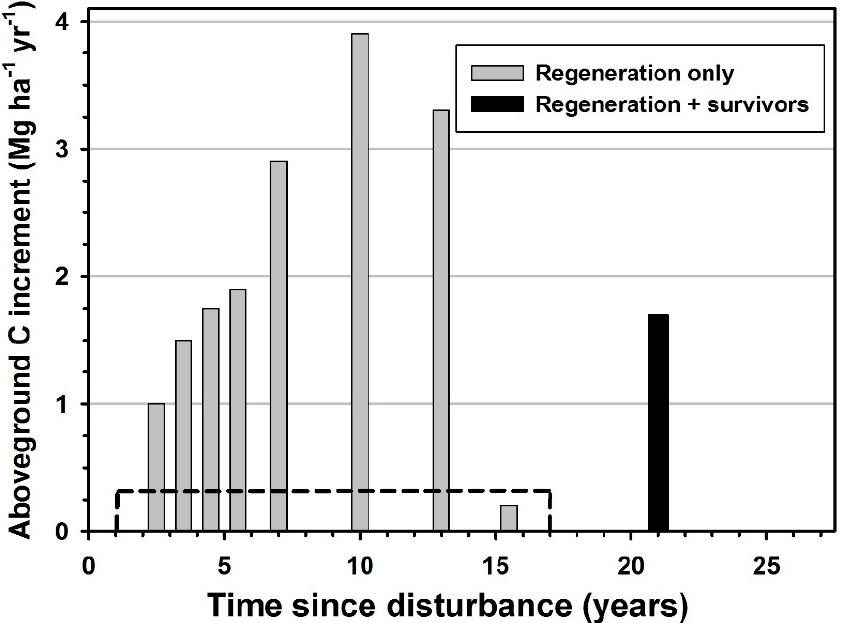
Figure 3. Annualized aboveground carbon increment between sample dates following catastrophic windthrow at the Tionesta Scenic Area, Pennsylvania. Bars are positioned at the midpoints of the sampling intervals; e.g., the combined (regeneration + survivors) bar is at 21 years because the endpoints of that period were 17 and 25 years. The dotted line represents the average annual carbon increment of survivors between years 1 and 17.